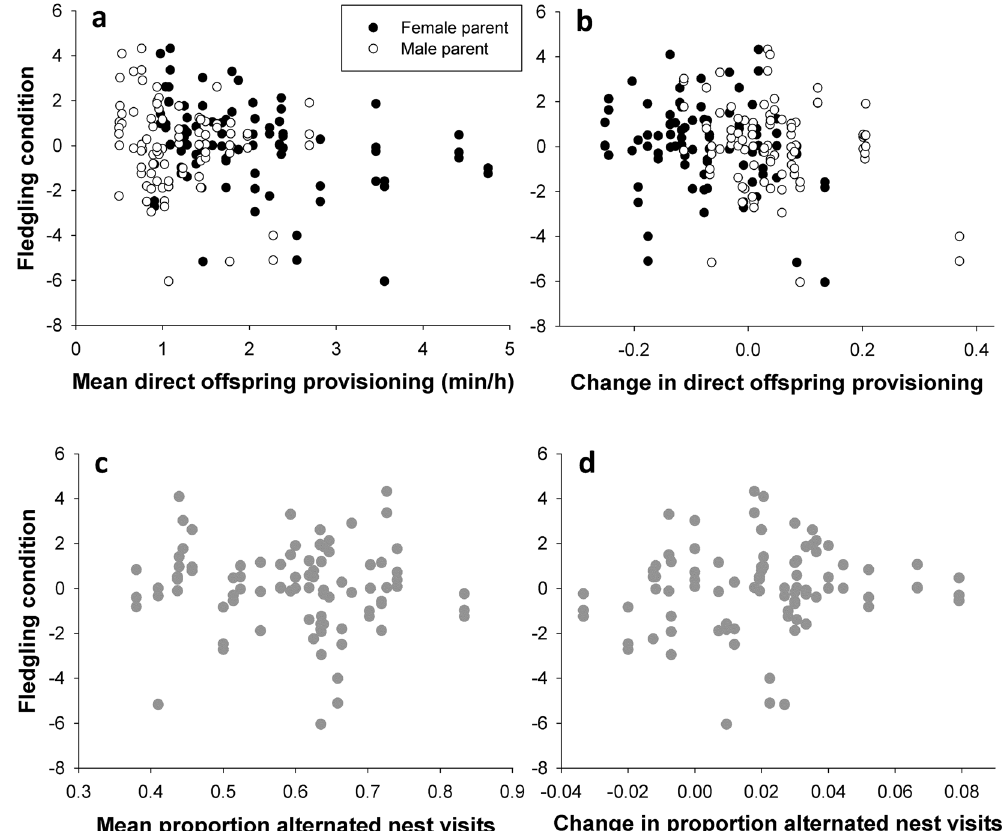
Figure 3. Fledgling condition as illustrative example for the absent relationships between offspring traits and estimates of parental care. Fledgling condition is here presented as the mass-by-tarsus length regression residuals, with positive values indicating heavy birds relative to their tarsus length and vice versa . Mean individual male (white dots) and female (black dots) provisioning ( a ) and pair (grey dots) alternation scores ( c ) are averaged values across three days (day 3, 8 and 13). Individual changes in both traits ( b , d ) are characterized as the slope of the behaviour-by-day regression. Fledgling condition was neither related to male mate feeding and female brooding and moreover, behavioural effects were consistently absent for the other offspring fitness parameters (all P > 0.05), except for NO levels (see